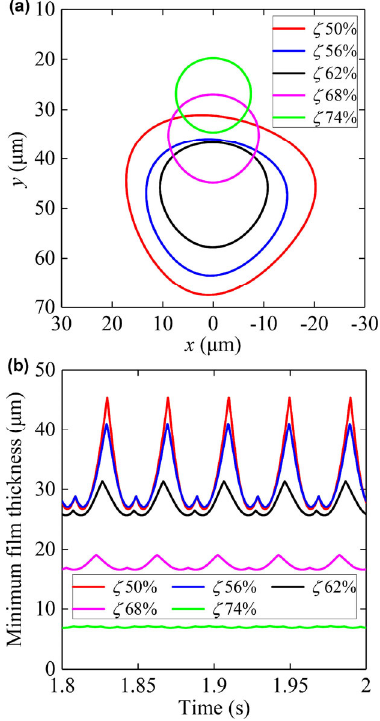
Fig. 6 (a) Journal center orbits and (b) dynamic minimum film thicknesses of a TPJB with static loads for different pivot